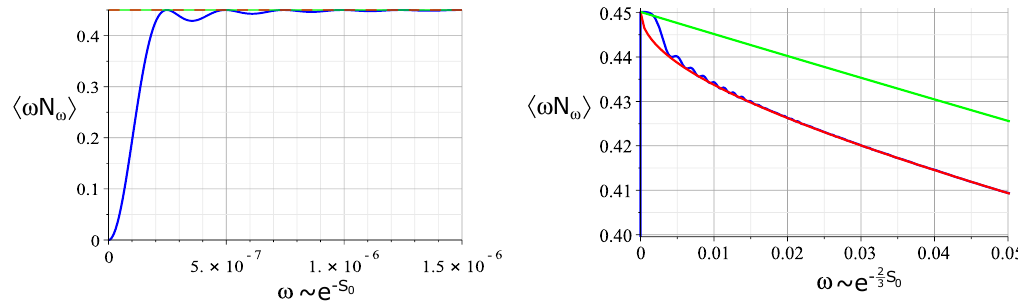
Figure 1 . (left) Zoom-in on the region with ω or order e − S 0 where we see level repulsion and high-frequency wiggles in the exact (blue) result. (right) Zoom-in on the region ω of order e − 2 S 0 / 3 where we see the slower Airy wiggles from the zero energy reference (3.22). Furthermore one sees that the Schwarzian answer (3.20) (red) is lower than the semi-classical answer (3.21) (green).